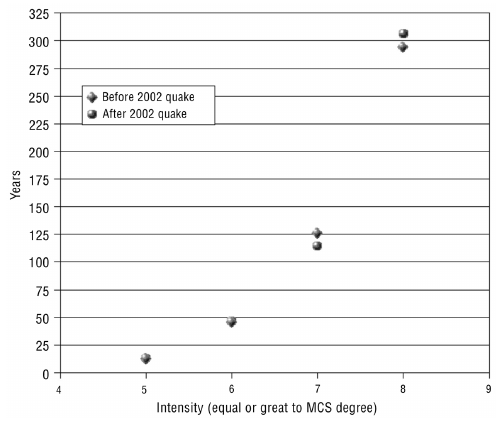
Fig. 5. Average return times estimated separately for intensities ranging from V to VIII degree MCS using the catalogue up to 2001 and then adding the 2002 event, following the procedure proposed by Al- barello and Mucciarelli